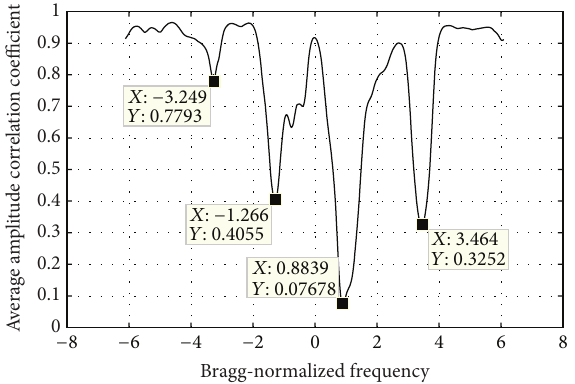
Figure 8: Amplitude correlation versus